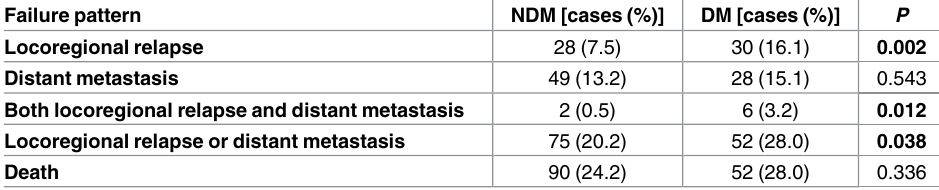
Table 2. Patterns of disease failure in the two groups of NDM and DM.